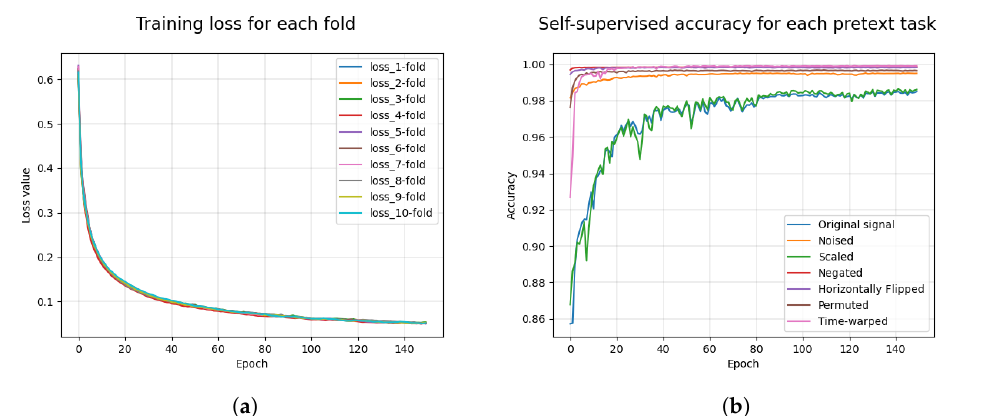
Figure 6. ( a ) Results of the loss functions obtained during the self-supervised training of the implemented neural network. ( b ) Accuracy results obtained in the test set for each of the seven pretext